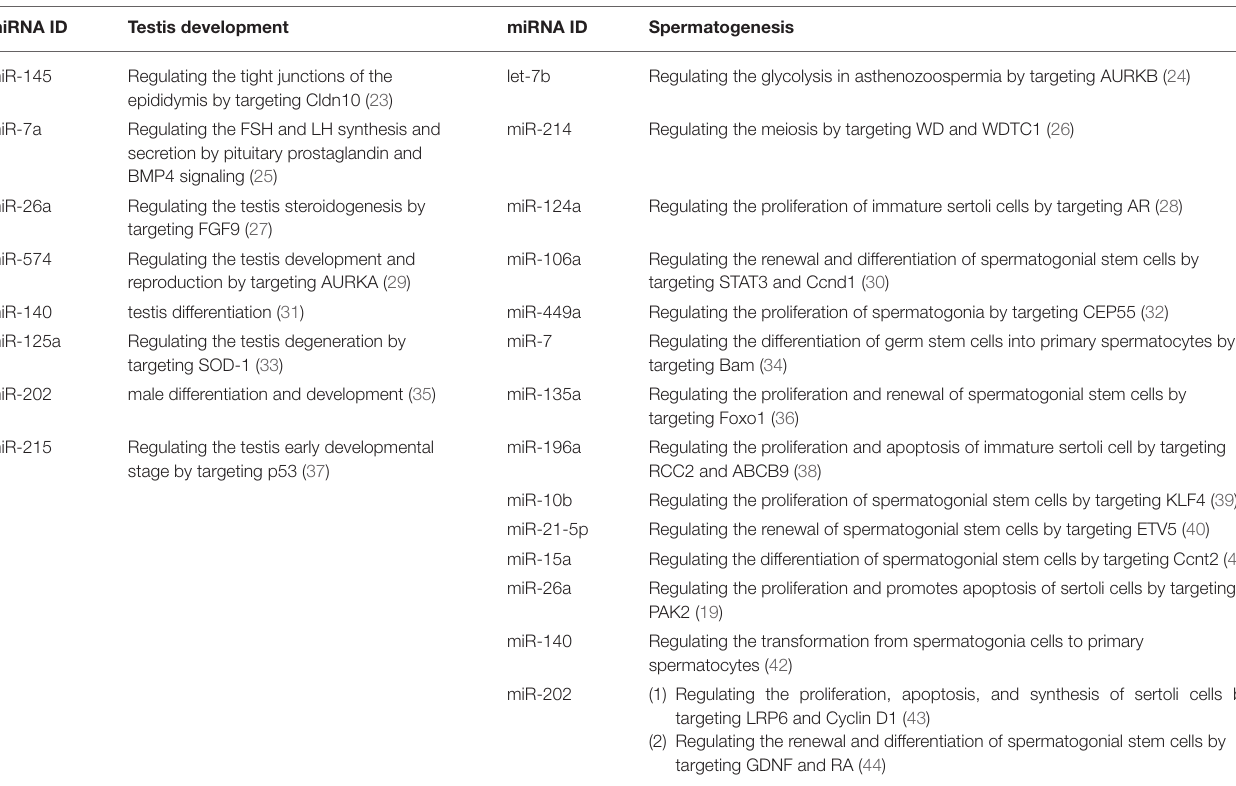
TABLE 2 | miRNAs identified in testis associated with testis development and spermatogenesis. miRNA